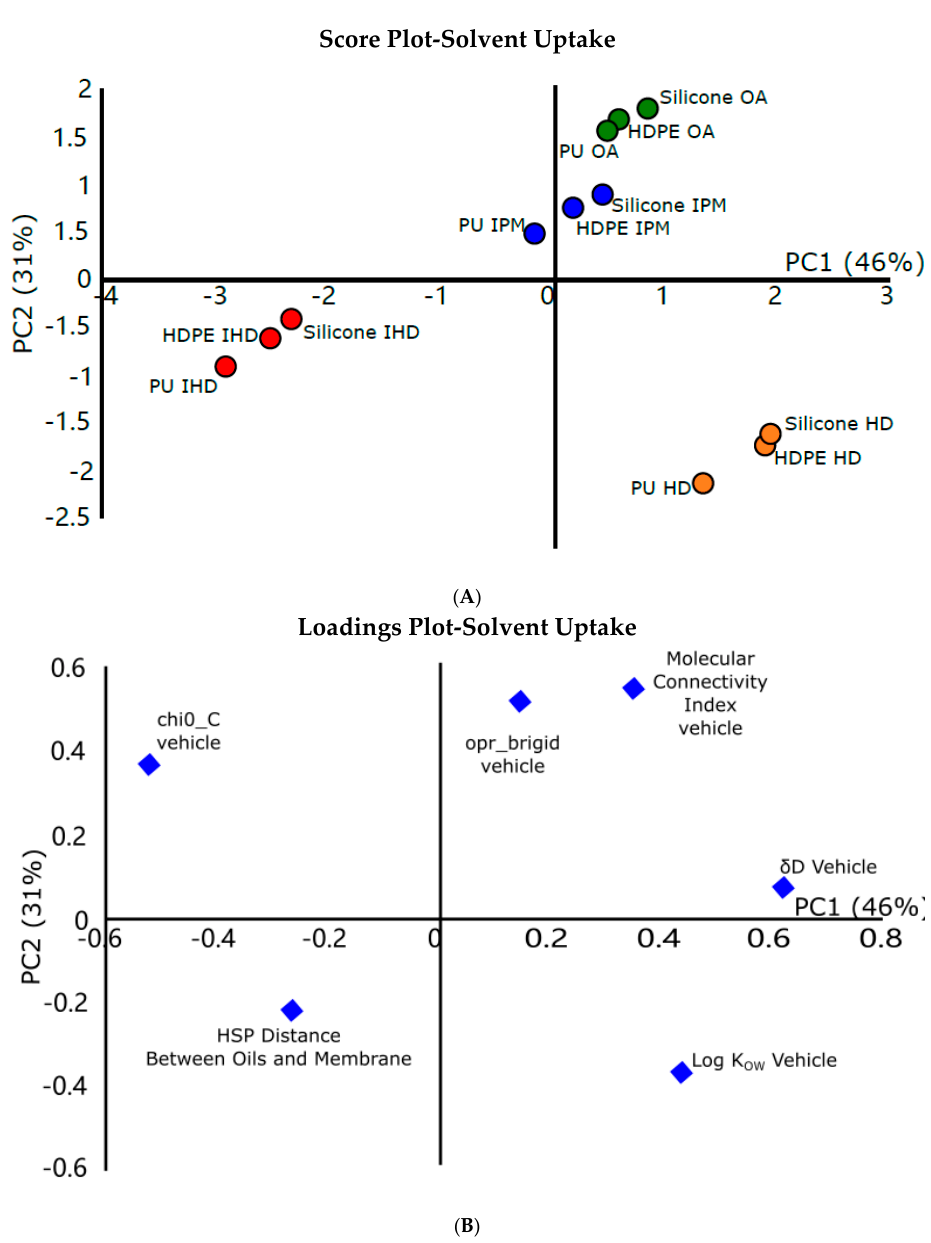
Figure 2. ( A ) Scores plot from the PCA of solvent uptake of oily vehicles into synthetic membranes showing clear groupings with respect to different vehicles (isohexadecane (IHD) in red, hexadecane (HD) in orange, oleic acid (OA) in green and isopropylmyristate (IPM) in blue). The first two principal components (PCs) explain 77% of the total variance in the dataset; 46% and 31% of the variability are explained by PC1 and PC2, respectively. ( B ) Loading plots from the PCA of the solvent uptake of oily vehicles into synthetic membranes showing descriptors, primarily related to describing the physicochemical properties of the vehicle, being highly loaded on PCs 1 and 2 and hence being most responsible for explaining the variation in solvent uptake observed.